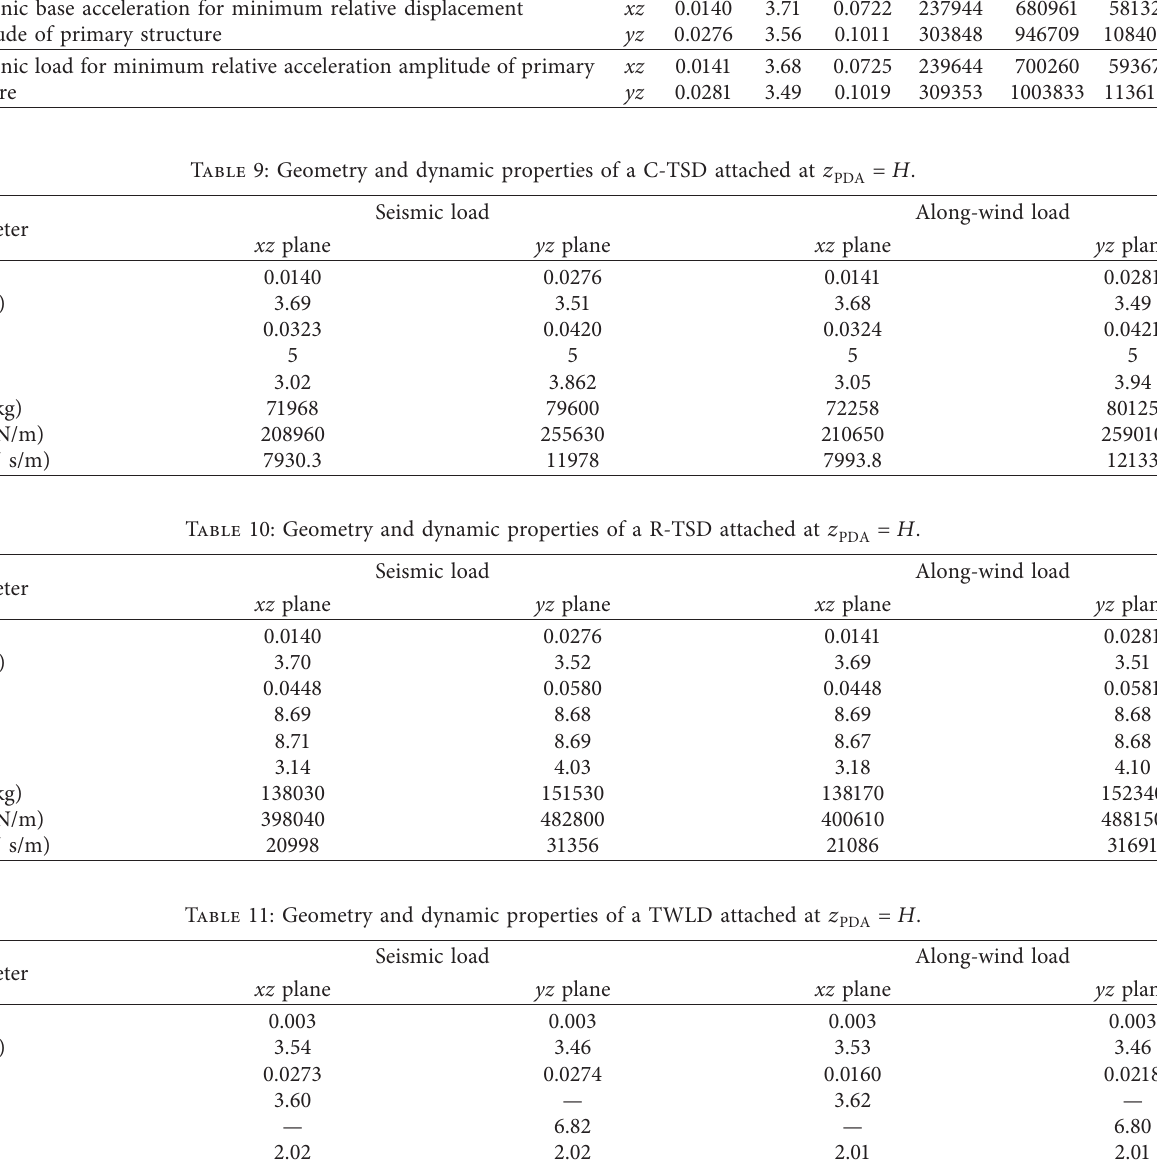
Table 8: Dynamic properties of a TMD attached at z